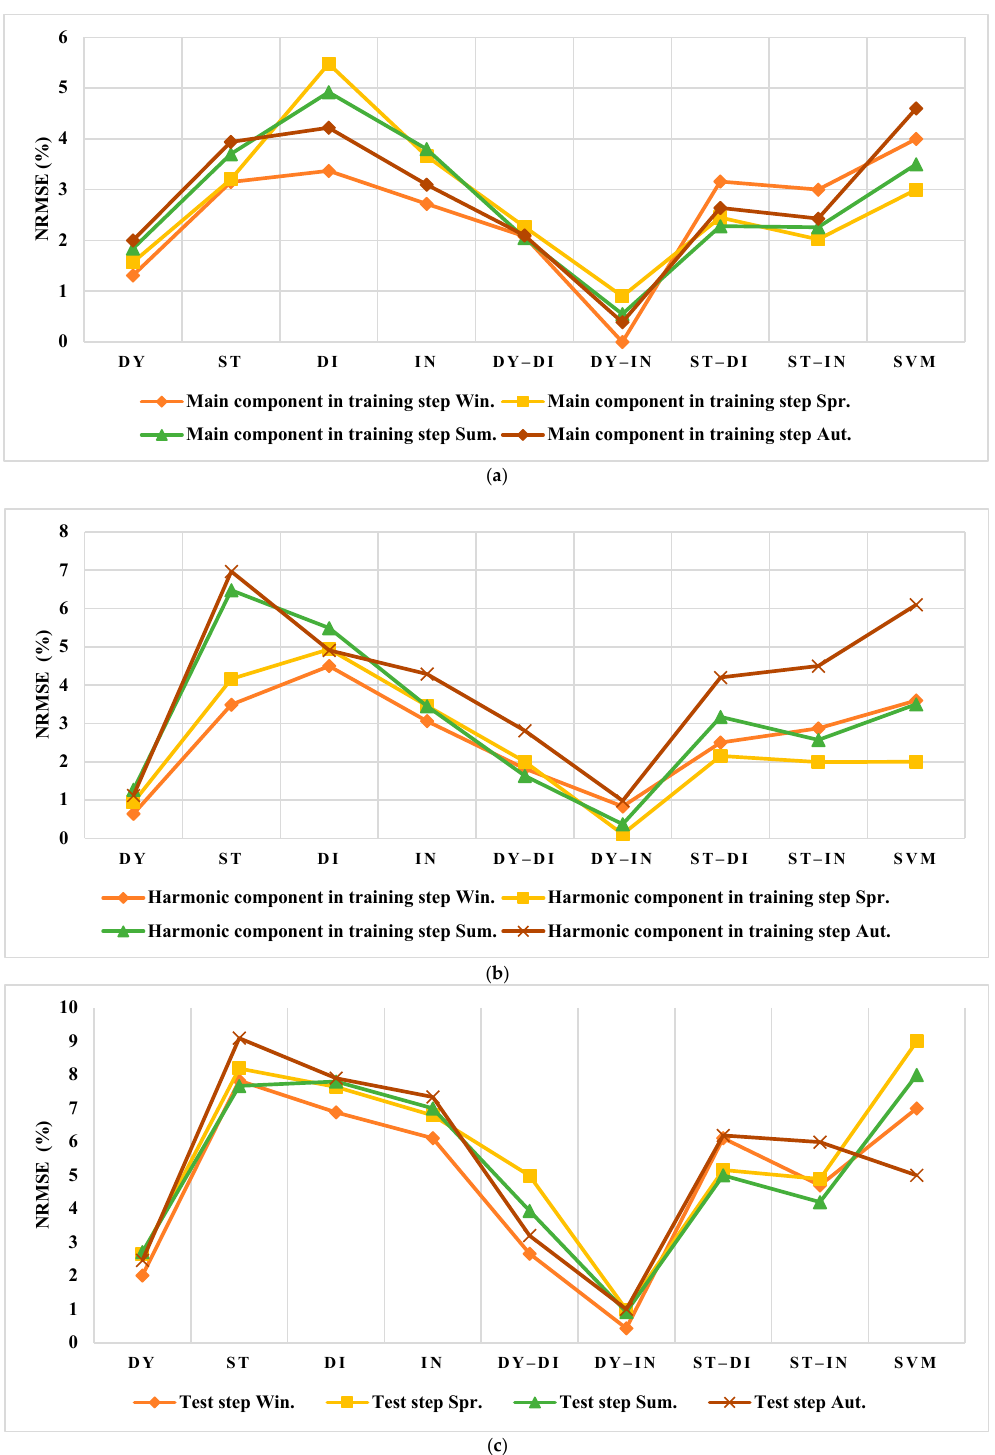
Figure 11. The results of MAPE (%) for Spain: ( a ) Main Component in training step, ( b ) Harmonic Component in training step, ( c ) Test step The results of NRMSE are presented in Figure 12. In this figure, the lowest values are related to the dynamic indirect GP. Other methods are weak in comparison with this method. Additionally, the best result obtained by the dynamic indirect GP in the test data is related to the winter with 0.43%. In addition, the NRMSE results of SVM are much higher than those of DY–IN, and are close to the DI and ST models.